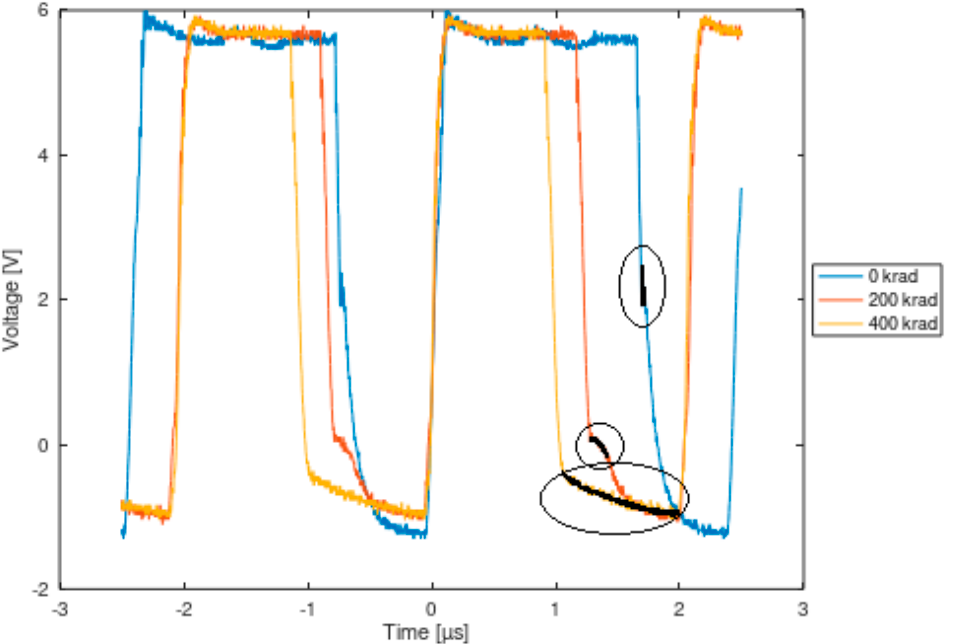
Figure 5. SUT010 MOSFET driver waveforms recorded at steps 0, 200 and 400 krad (X-ray irradiation). Black color marks switching time for each irradiation step. Switching time is approximately 3 times longer for 200 krad (than prerad) and more than 15 times longer for 400 krad (than prerad).